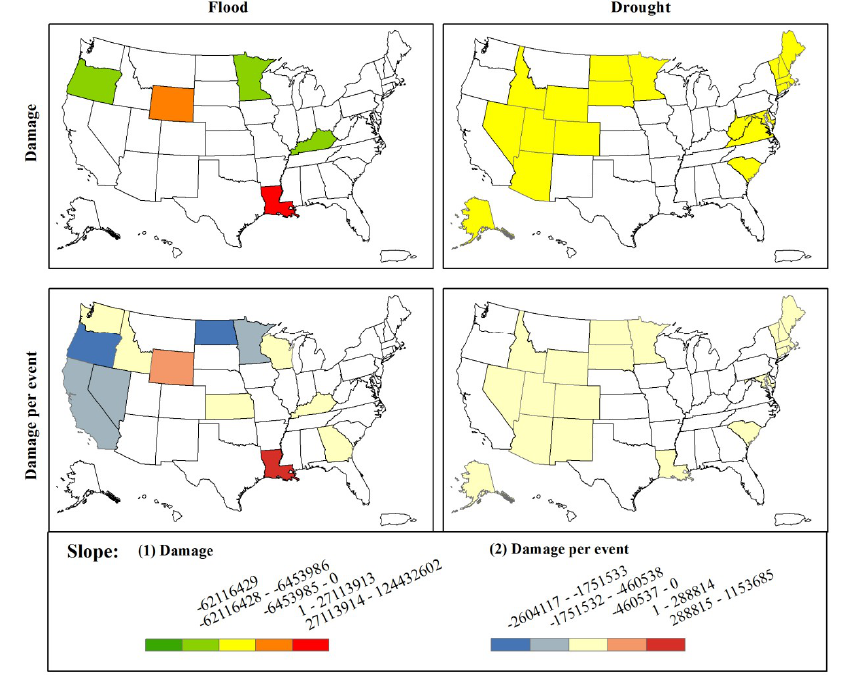
Figure 5. Trends in annual damage (D) (first row) and damage per event (DPE) (second row) of floods and droughts. Only states with statistically significant relations at the 90% confidence level are shown. As for droughts, both NED and SDE have decreased across the country except for Mississippi, Arkansas and Texas (Figure 4). Among the 25 states with decreasing number of damaging